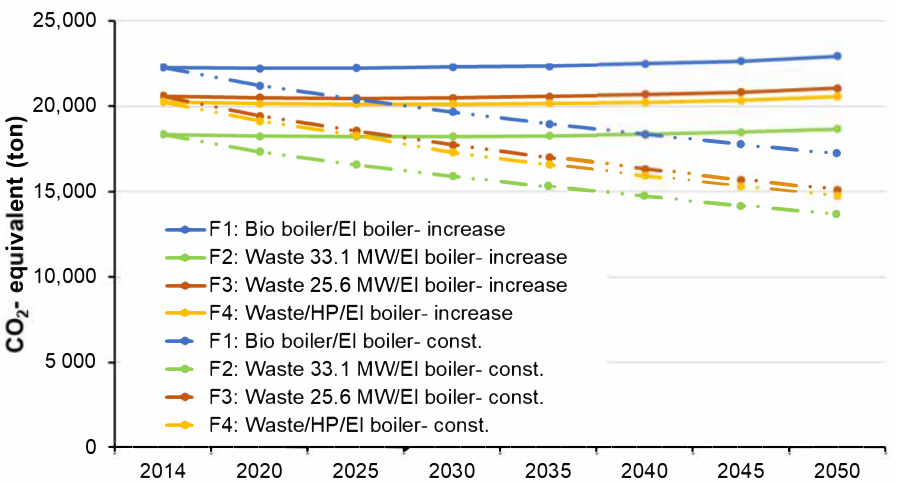
Figure 12. Comparison of the CO 2 emissions for the increasing and constant building